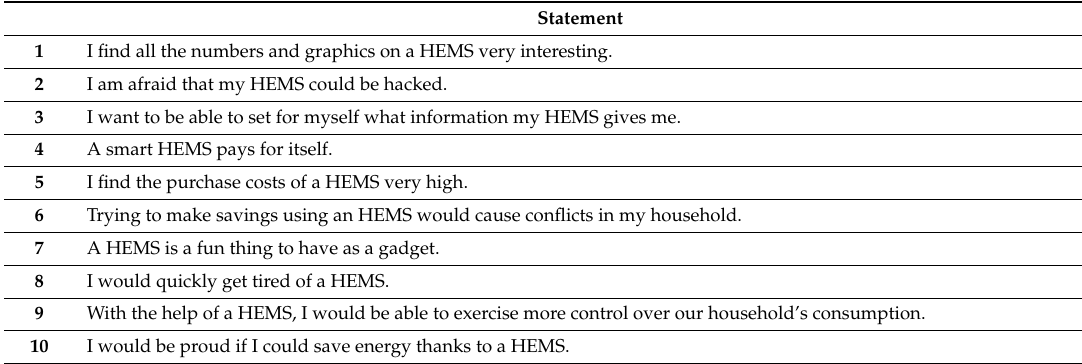
Table 2. Statements in